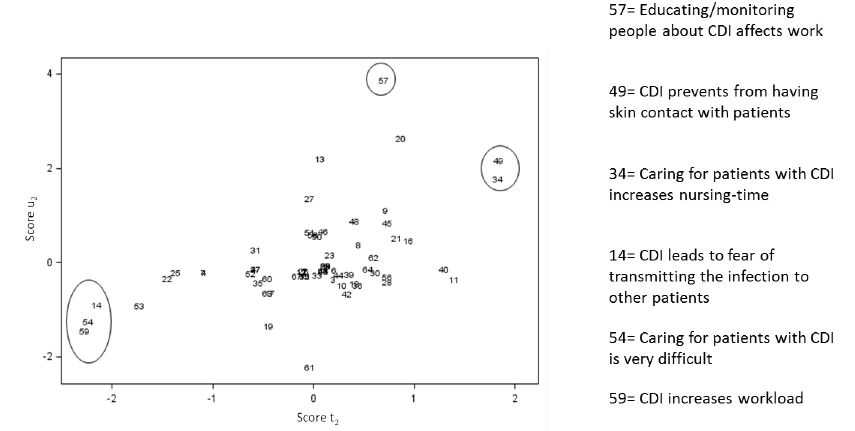
Fig 5. Projection of the themes in the space of the predictor score (t2) and the response variable scores (u2) according to the second PLS factor (N = 67).